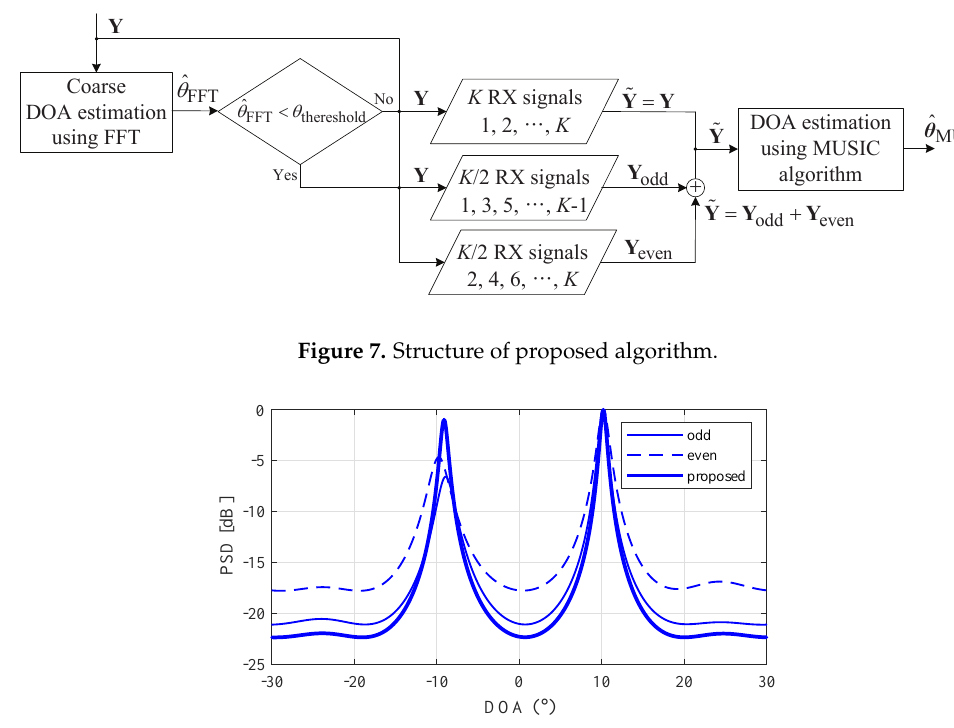
Figure 8. Snapshot of PSD of MUSIC algorithm according to input.